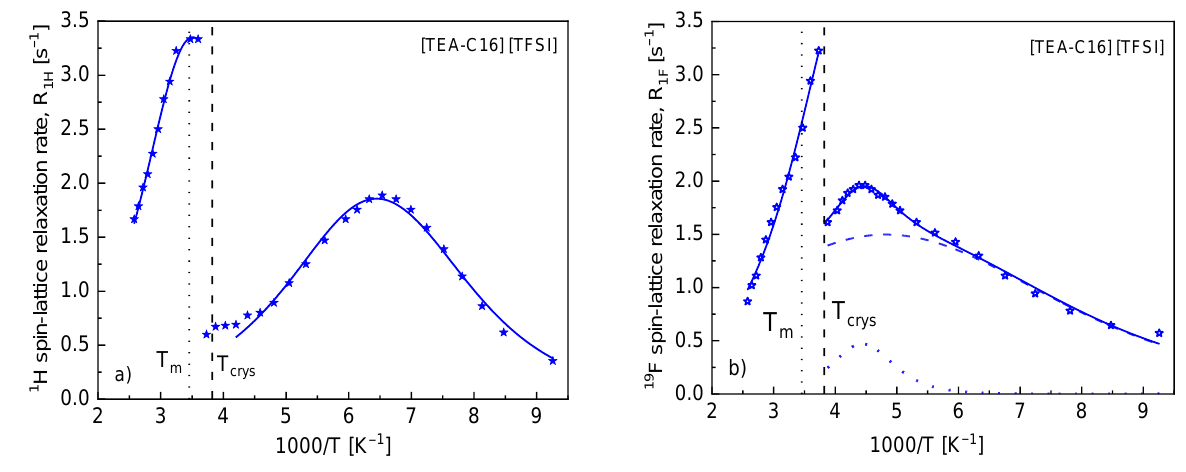
Figure 5. 1 H ( a ) and 19 F ( b ) spin-lattice relaxation rates versus reciprocal temperature for [TEA- C16][TFSI]. Solid and dashed green lines—fits with parameters collected in Table 4, dashed line in ( b ) — relaxation contribution related to the parameters 𝐶 𝐷𝐷,1𝑙 , 𝜏 0,1𝑙 , 𝐸 𝐴,1𝑙 , dotted line in ( b ) — relaxation contribution related to the parameters 𝐶 𝐷𝐷,2 𝑙 , 𝜏 0,2 𝑙 , 𝐸 𝐴,2 𝑙 ,vertical lines indicate phase transition tem- peratures ( 𝑇 𝑚 = 289.41 K, 𝑇 𝑐𝑟𝑦𝑠𝑡 = 261.69 K [26]). Table 4. Parameters obtained from the analysis of the 1 H and 19 F spin-lattice relaxation data for [TEA-C16][TFSI].